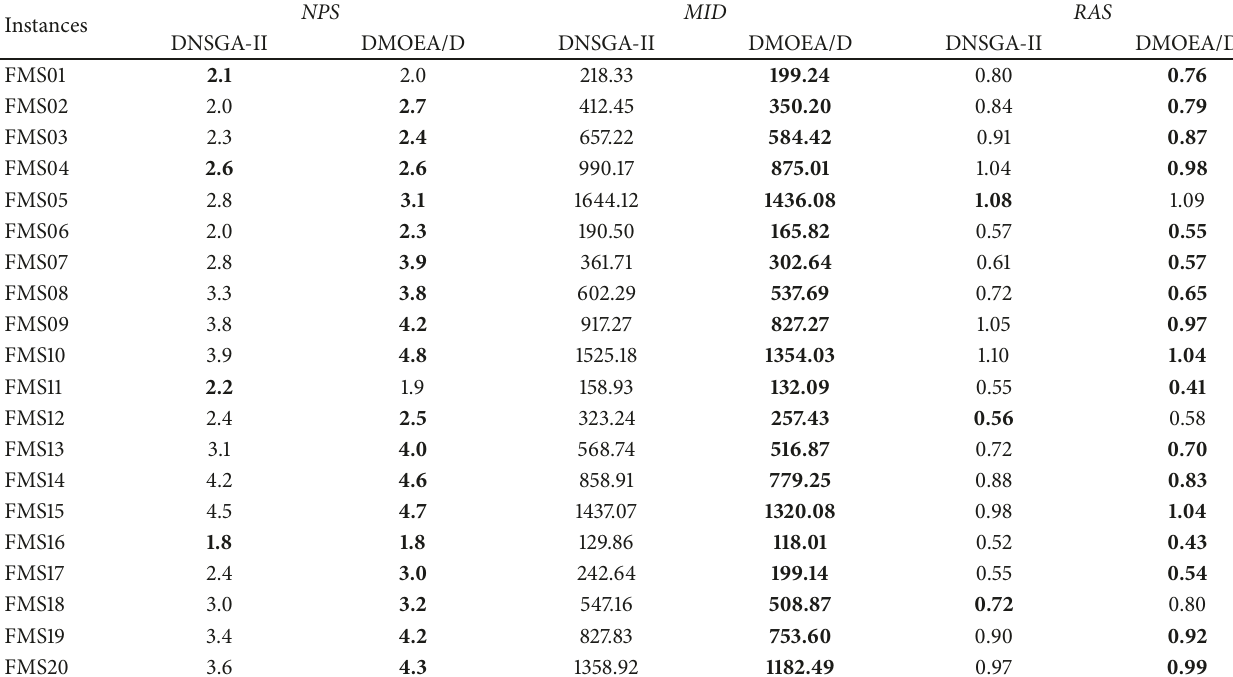
Table 3: Scheduling results of 2-objective problem